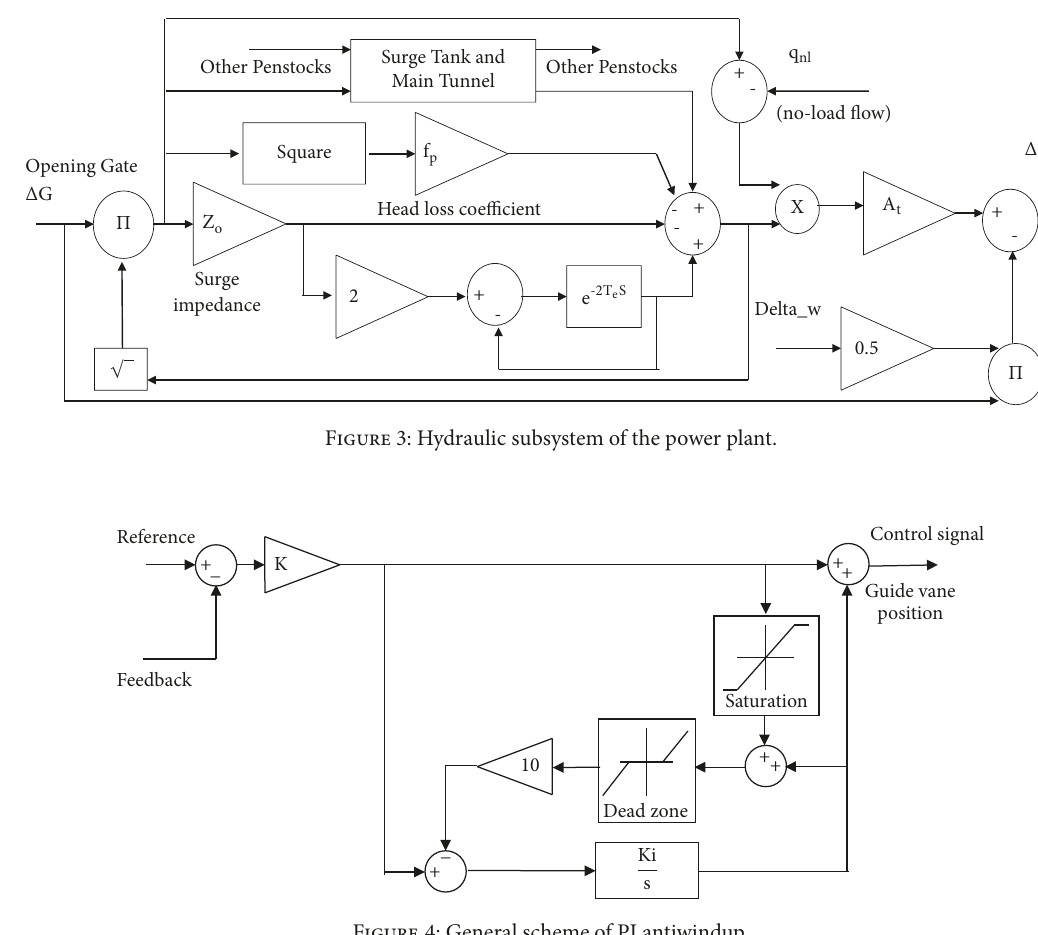
Figure 4: General scheme of PI